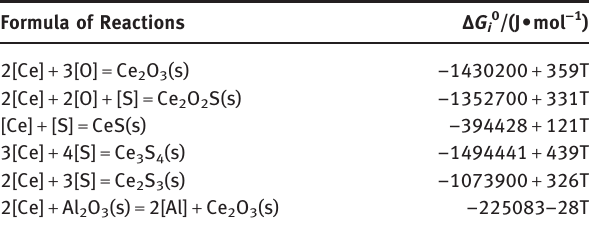
Table 4: Standard Gibbs energy of formation of Ce inclusion. Formula of